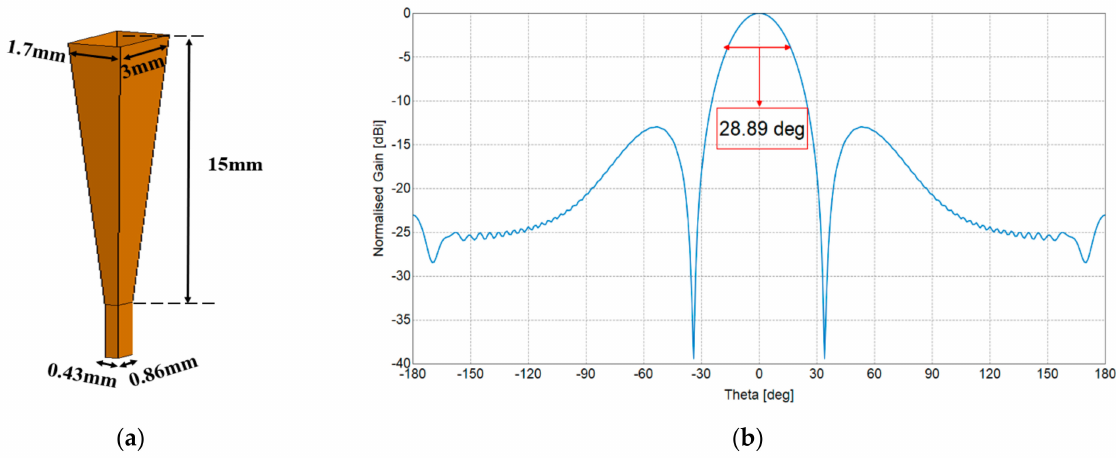
Figure 11. Horn antenna for experiment with detailed dimensions. ( a ) The geometry of the horn antenna. ( b ) The E-plane